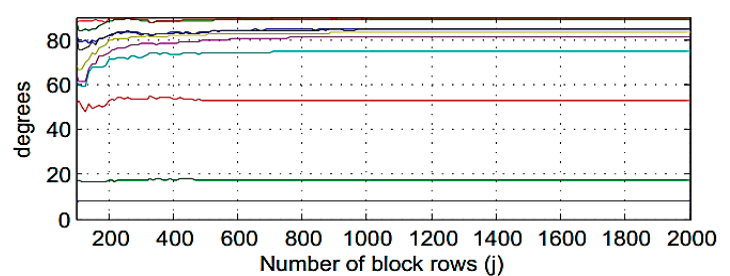
Figure 4. Principle angles in function of the block rows number (j) for subspace algorithms using CVA. Poles of the simulation system are extracted from the system parameters of the SSI algorithm.